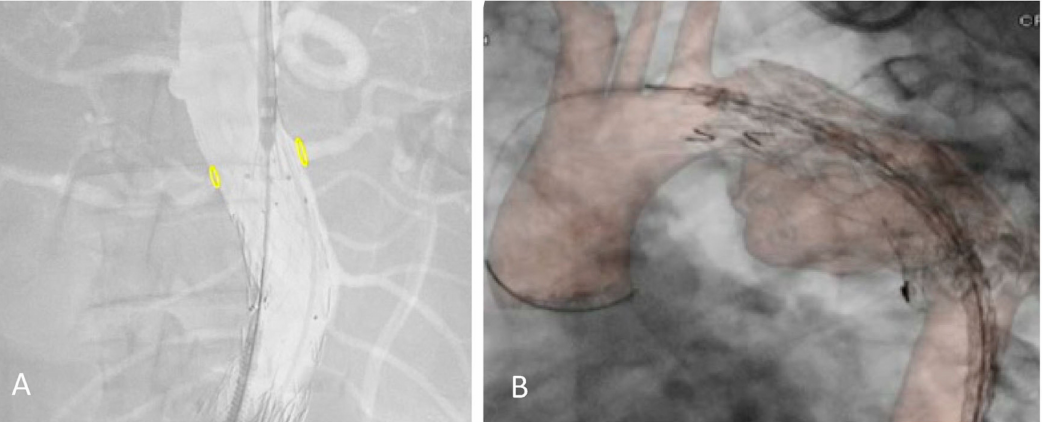
Figure 1. Proximal relining for type IA endoleak in a previous EVAR ( A ) and TEVAR ( B ) under the redo fusion technique. Accuracy of the yellow markers on bilateral renal arteries after shaft device insertion and in the thoracic